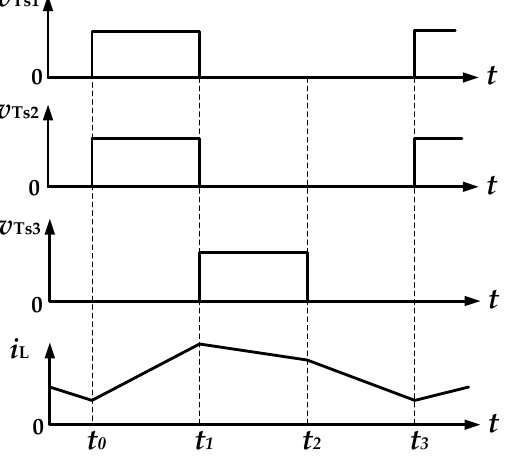
Figure 4. Waveforms in single input dual output (SIDO) mode.